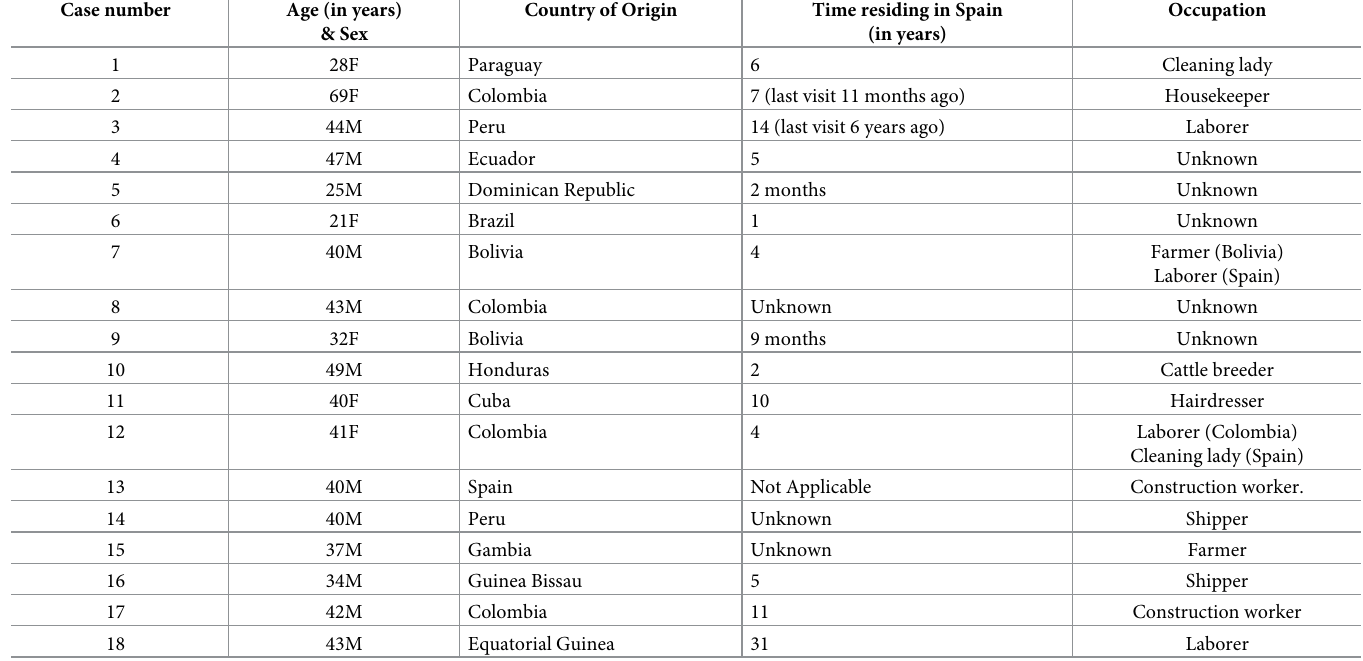
Table 1. Epidemiological